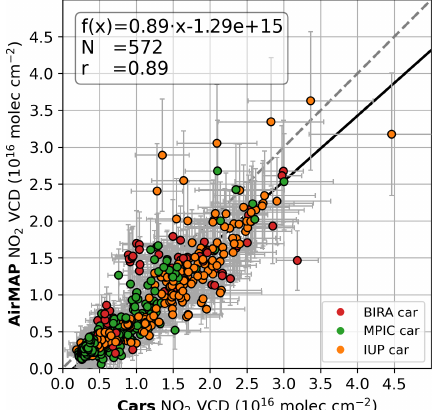
Figure 7. Scatter plot between co-located car DOAS ( ± 15min win- dow from the aircraft overpass) and AirMAP NO 2 VCDs using grid boxes of 500m × 500m and 15min time intervals. The data points from BIRA, MPIC, and IUP car DOAS instruments are color coded in red, green, and orange, respectively. The 1:1 line is in- dicated by the dashed grey line. The thick solid black line repre- sents the orthogonal distance regression. Error bars represent the error in the tropospheric NO 2 VCD retrieval, averaged within the 500m × 500m grid boxes and 15min time